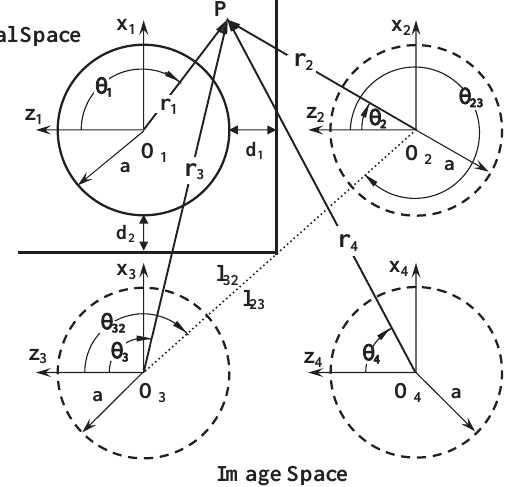
Fig. 2. Source-image configuration for the acoustic quarterspace